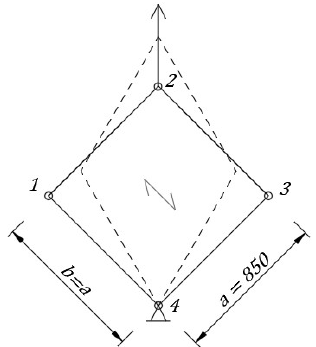
Figure 1. Static scheme of the experimental set-up [mm].